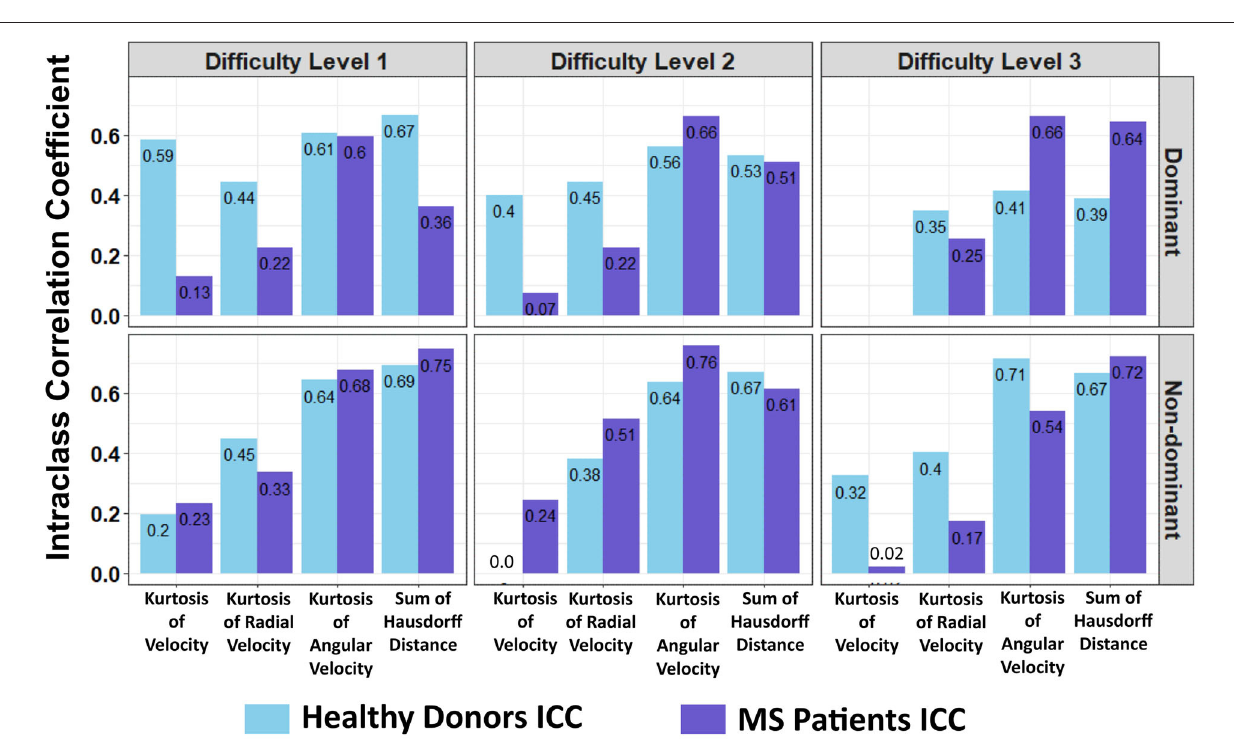
Frontiers in Medical Technology |